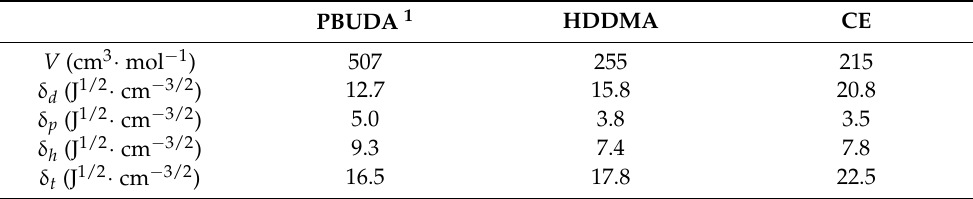
Table 2. Solubility parameters calculated for each monomer in this study. PBUDA 1